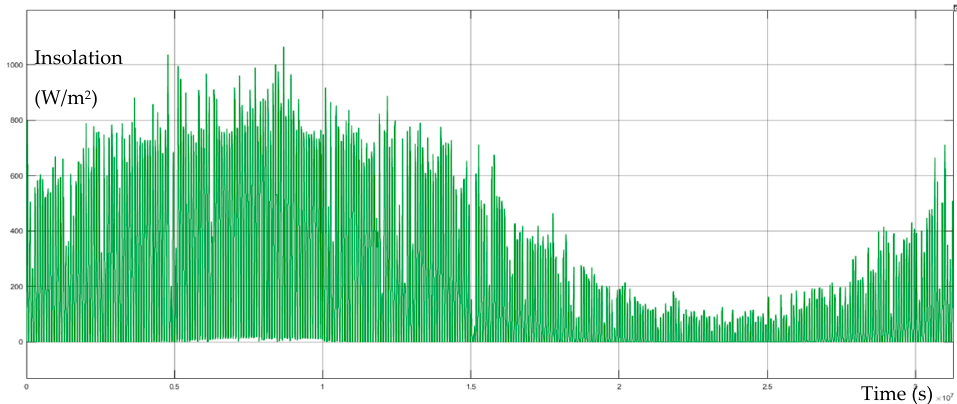
Figure 1. Insolation (W/m 2 ) in Chelyabinsk city, Russia during the year 2020, starting from April.